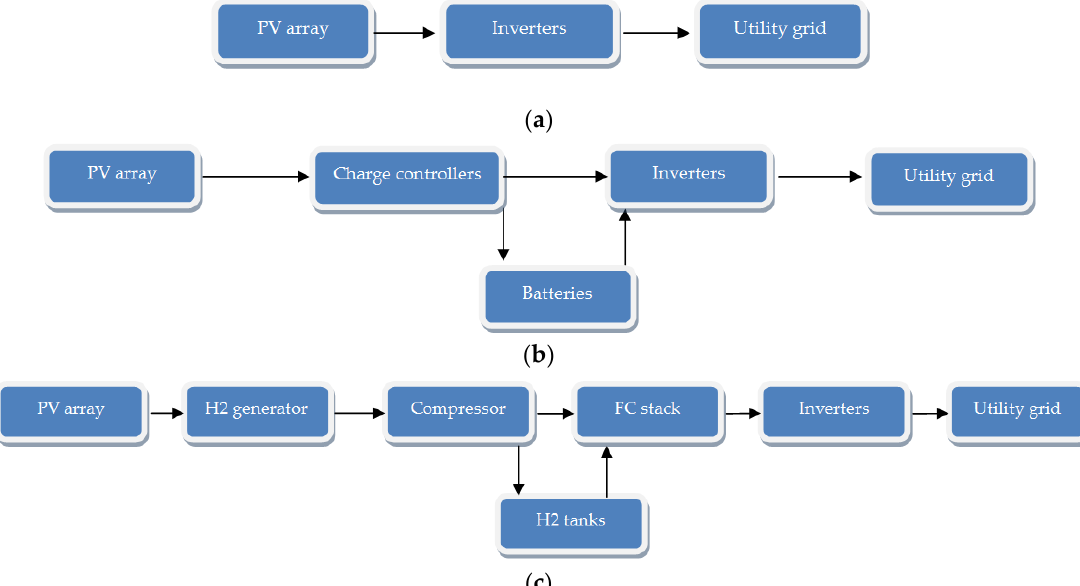
Figure 1. Block schemes of three investment scenarios: ( a ) without electricity storage, ( b ) with energy storage in batteries, ( c ) with energy storage in hydrogen.